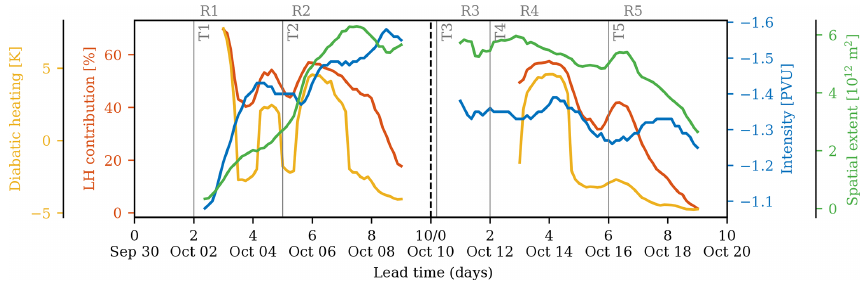
Figure 2. Percentage of trajectories with (cid:49)θ > 2K in 3d (red, %), mean diabatic heating along the blocking trajectories (yellow, K, calculated as the mean change in θ along all (heated and non-heated) trajectories), blocking intensity (blue, right axis, pvu), and spatial extent (green, second right axis, 10 12 m 2 ) as a function of time (simulation lead time and date) for Thor onset and maintenance. Note that 3d backward trajectories can only be calculated after day 3. Labels “T1–T5” and “R1–R5” refer to the troughs and ridges during the time of their interaction with the block Thor. Note that no block is detected between 9 and 11 October as a result of the 2d temporal smoothing of the upper-level PV-anomaly